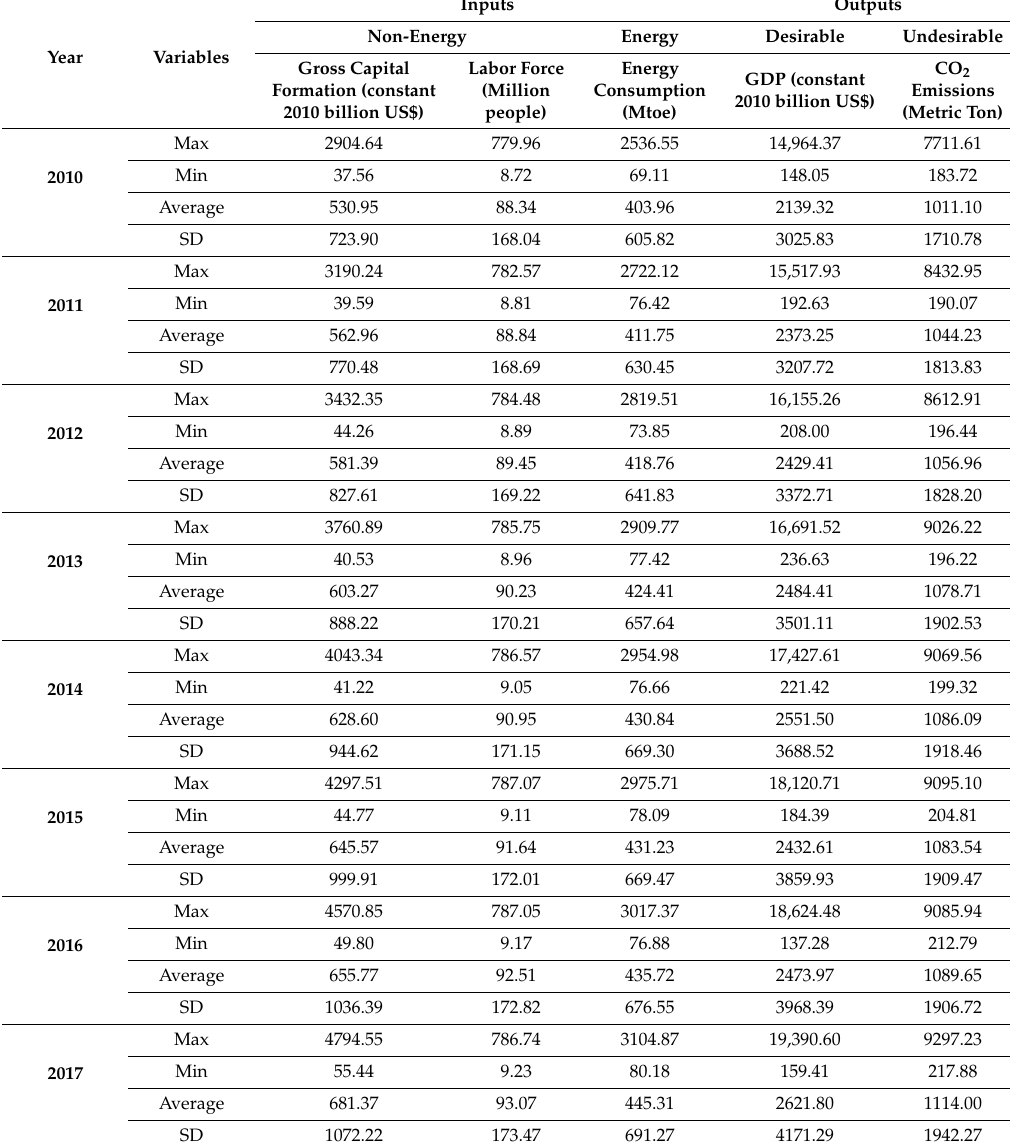
Table 1. Summary for the research samples during